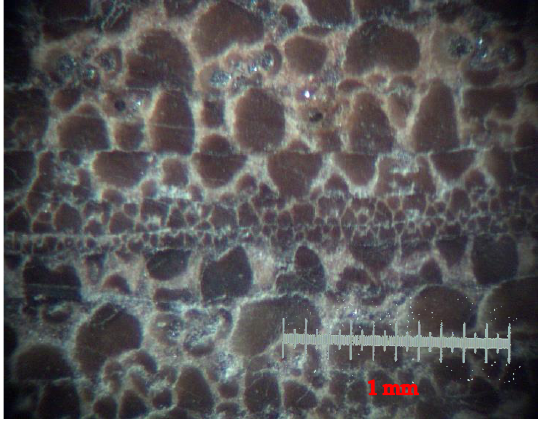
Figure 3. Cross section of